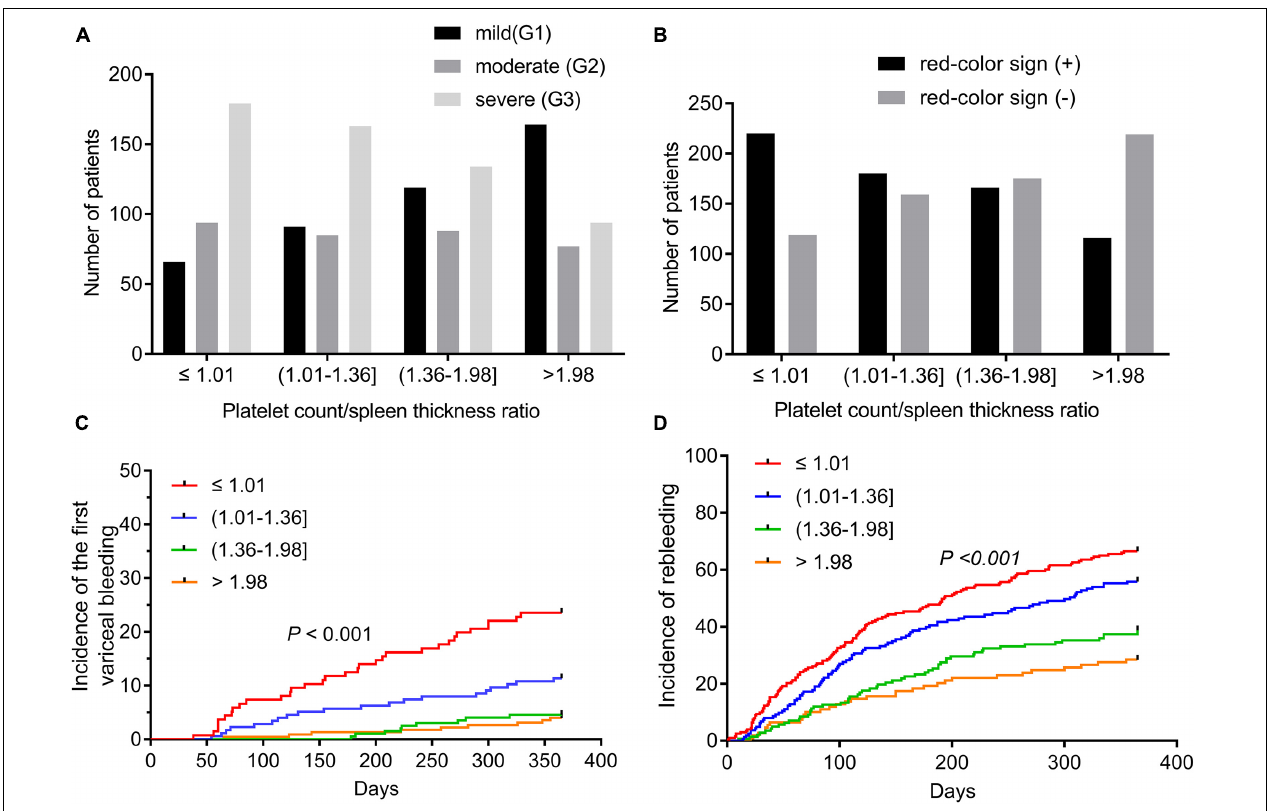
FIGURE 2 | Esophagogastric varices and variceal bleeding of cirrhotic patients according to the quartiles of the platelet count to spleen thickness ratio. (A) Grades of esophagogastric varices in cirrhotic patients according to the quartiles of the platelet count to spleen thickness ratio. (B) The red color sign of esophagogastric varices according to the quartiles of the platelet count to spleen thickness ratio. (C) The incidence of the first variceal bleeding episode within 1 year in cirrhotic patients with esophagogastric varices according to the quartiles of the platelet count to spleen thickness ratio. (D) The incidence of rebleeding within 1 year in cirrhotic patients who suffered from their first EGVB according to the quartile of the platelet count to spleen thickness ratio. EGV, esophagogastric varices; EGVB, esophagogastric variceal bleeding.